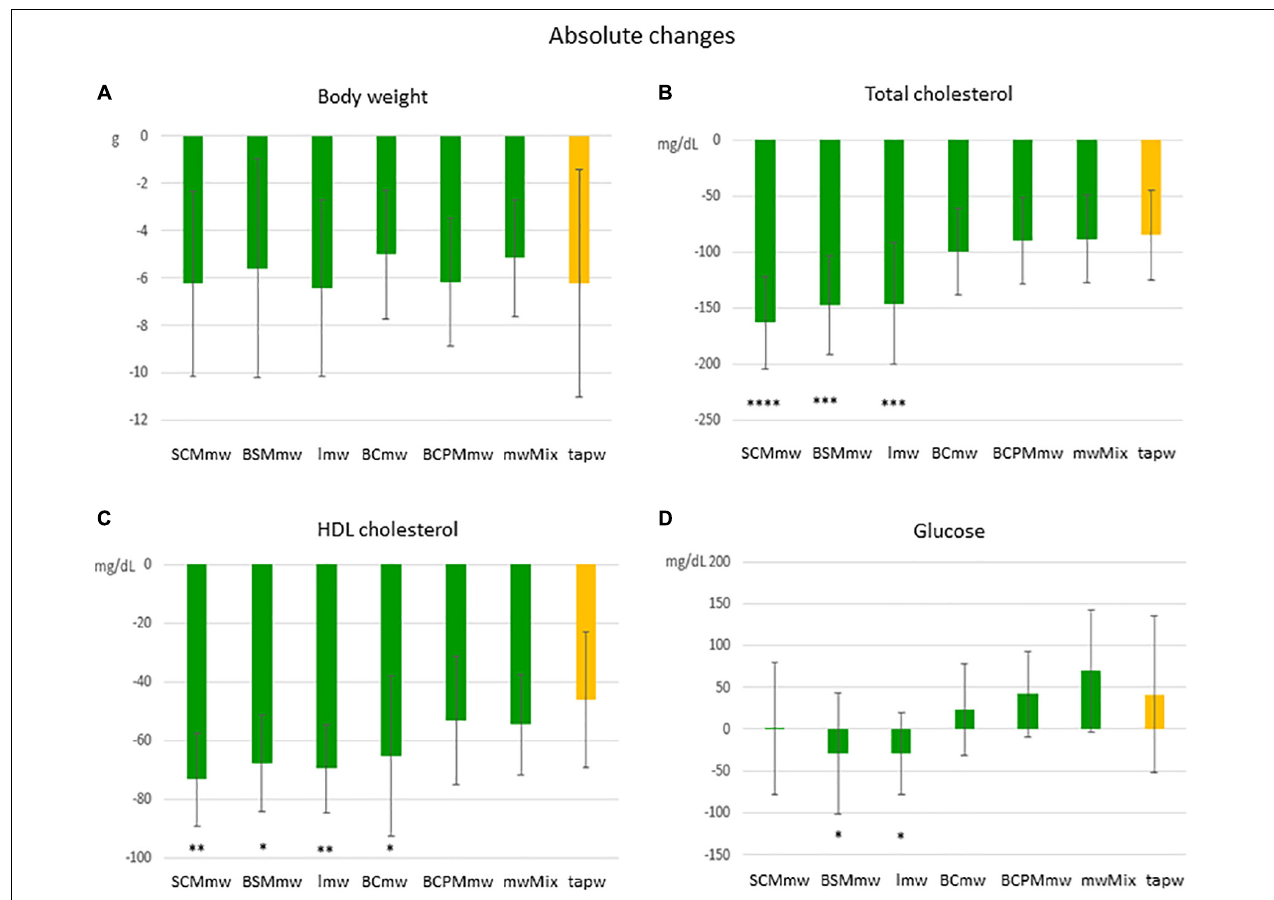
FIGURE 3 | Main effect of treatment on absolute changes in physical and biochemical parameters among treated mice. The figure shows average absolute differences (T6–T4 ± SDs; A–D ) in physical and biochemical parameters in different mineral water-treated mice and tap water-treated control group. Each group includes both males and females. The groups are: SCMmw, sulphate-, calcium-, and magnesium-rich mineral water; BSMmw, bicarbonate-, sulphate-, and magnesium-rich mineral water; lmw, light mineral water; BCmw, bicarbonate- and calcium-rich mineral water; BCPMmw, bicarbonate-, calcium-, potassium-, and magnesium-rich mineral water; mwMix, alternation of NMWs; tapw, low mineral content tap water. Between-group analysis for the effect of treatment was performed by one-way ANOVA, followed by Dunnett’s test, comparing each group against the control group. * P ≤ 0.05, ** P ≤ 0.01, *** P ≤ 0.001, and **** P ≤